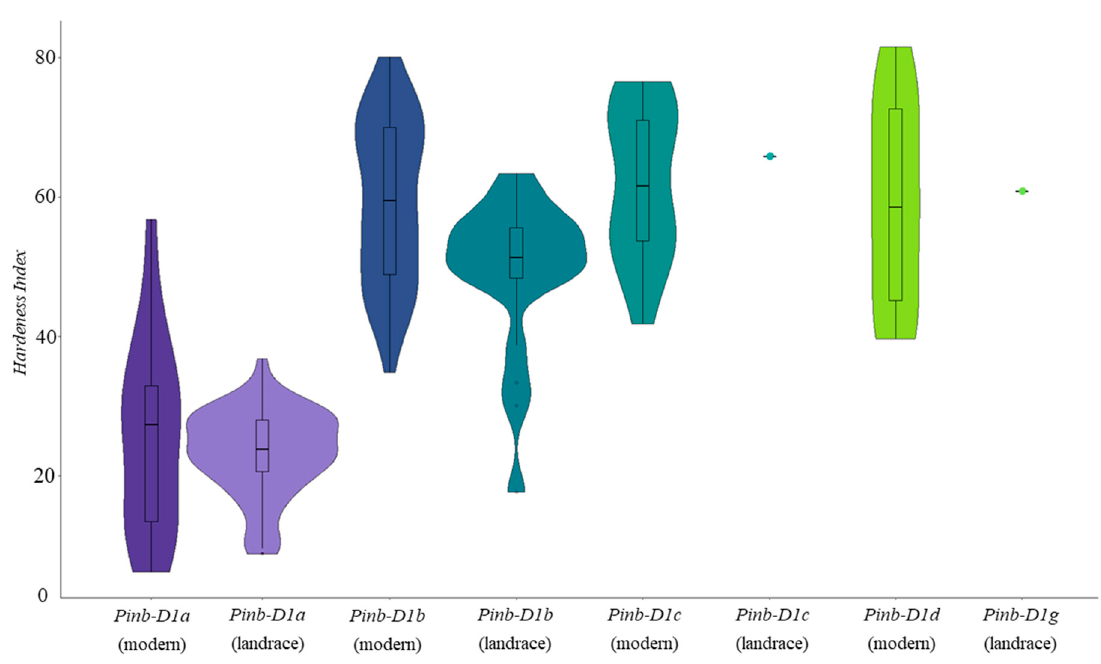
Figure 3. Hardness index ranges for individual Pinb alleles divided into modern wheats and landraces. The widths of the figures indicates the frequency of occurrence of a given hardness index.